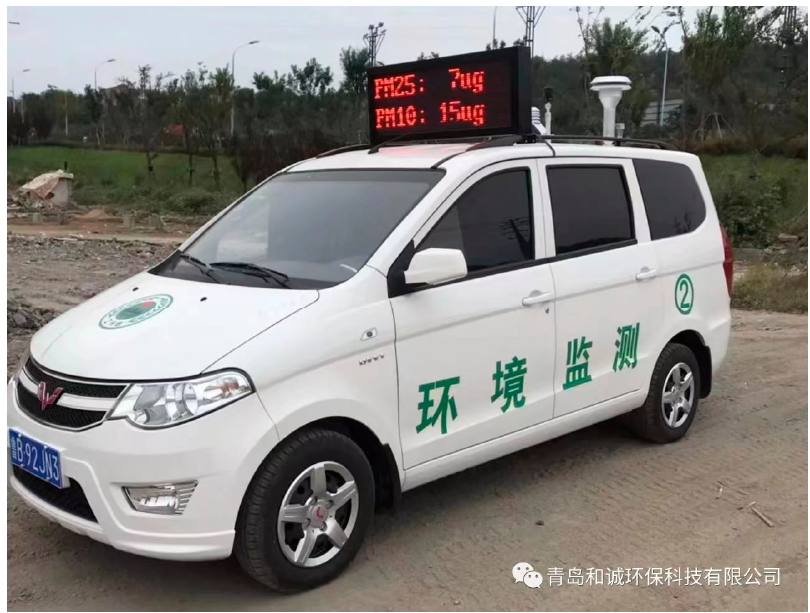
Figure 7. A mobile AQI monitoring station, used by EMULSION.